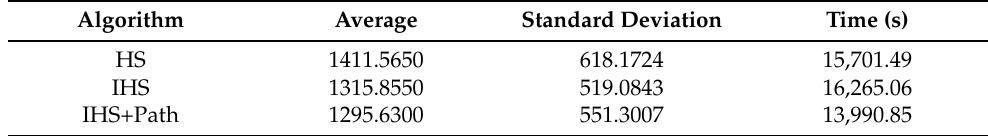
Table 4. Convergence analysis results for the 84-bus test